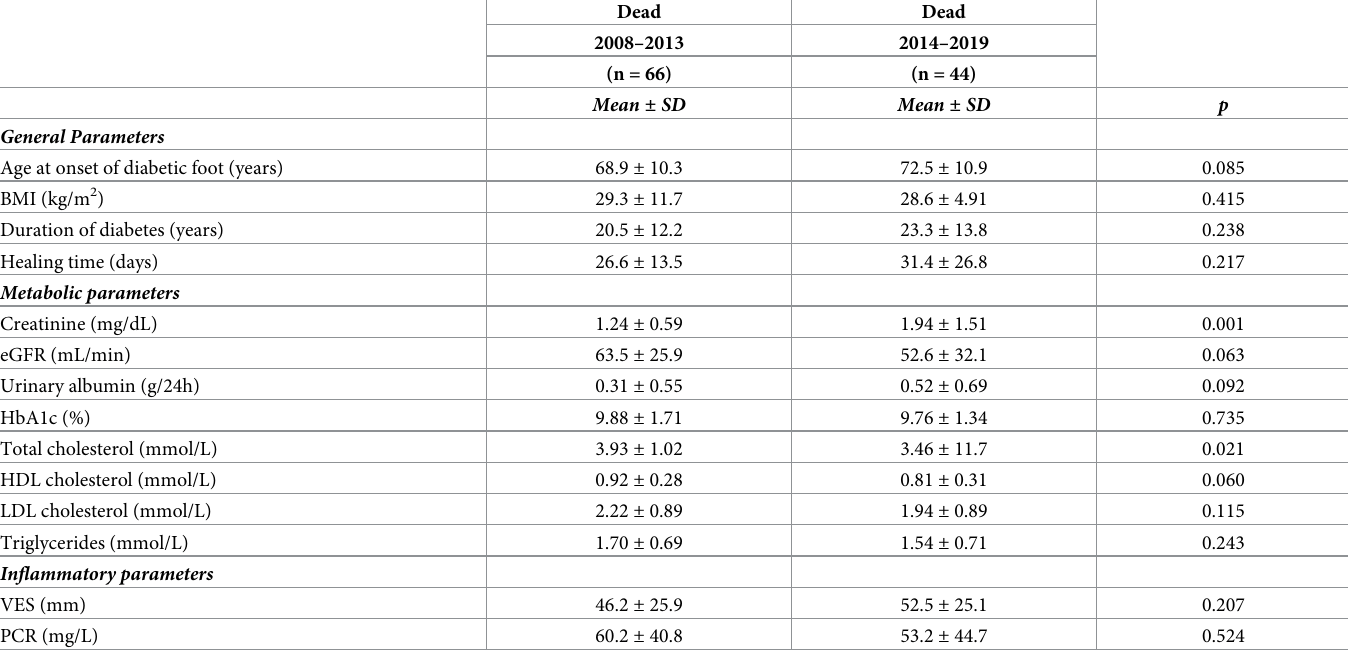
impairment correlates strongly with the incidence and prevalence of DFU with an adjusted OR equal to 1.61. Wolf et al. reported that impaired renal function was an independent predic- tor of all-cause mortality and cardiovascular deaths [30]. In the current study, eGFR < 92 ml/ min was found to be a predictor of mortality with an OR of 2.84. These results are in line with those obtained by Ghanassia et al. who demonstrated that CKD was the only independent pre- dictor of mortality in patients with DFU [31]. Similarly, in our cohort of Sicilian Type 2 Table 5. Clinical, metabolic and inflammatory parameters in dead patients with diabetic foot complication divided according period of